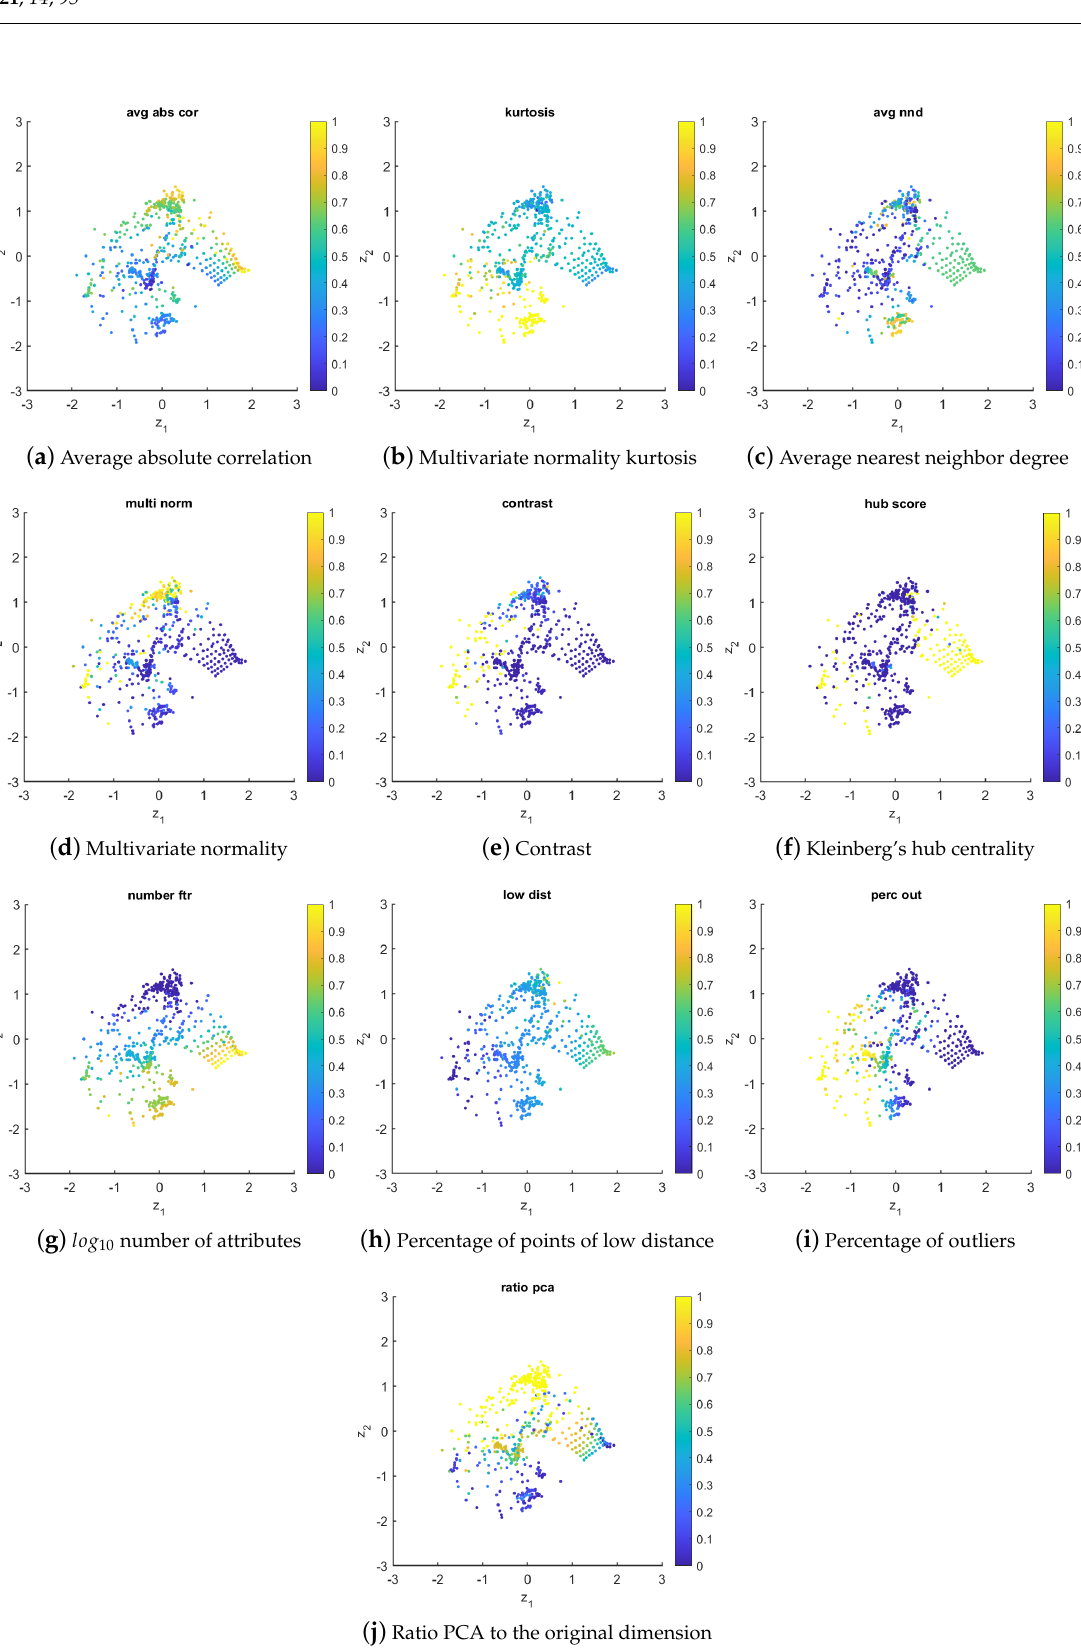
Figure 9. Distribution of selected meta–features on the projected instance space after the inclusion of real